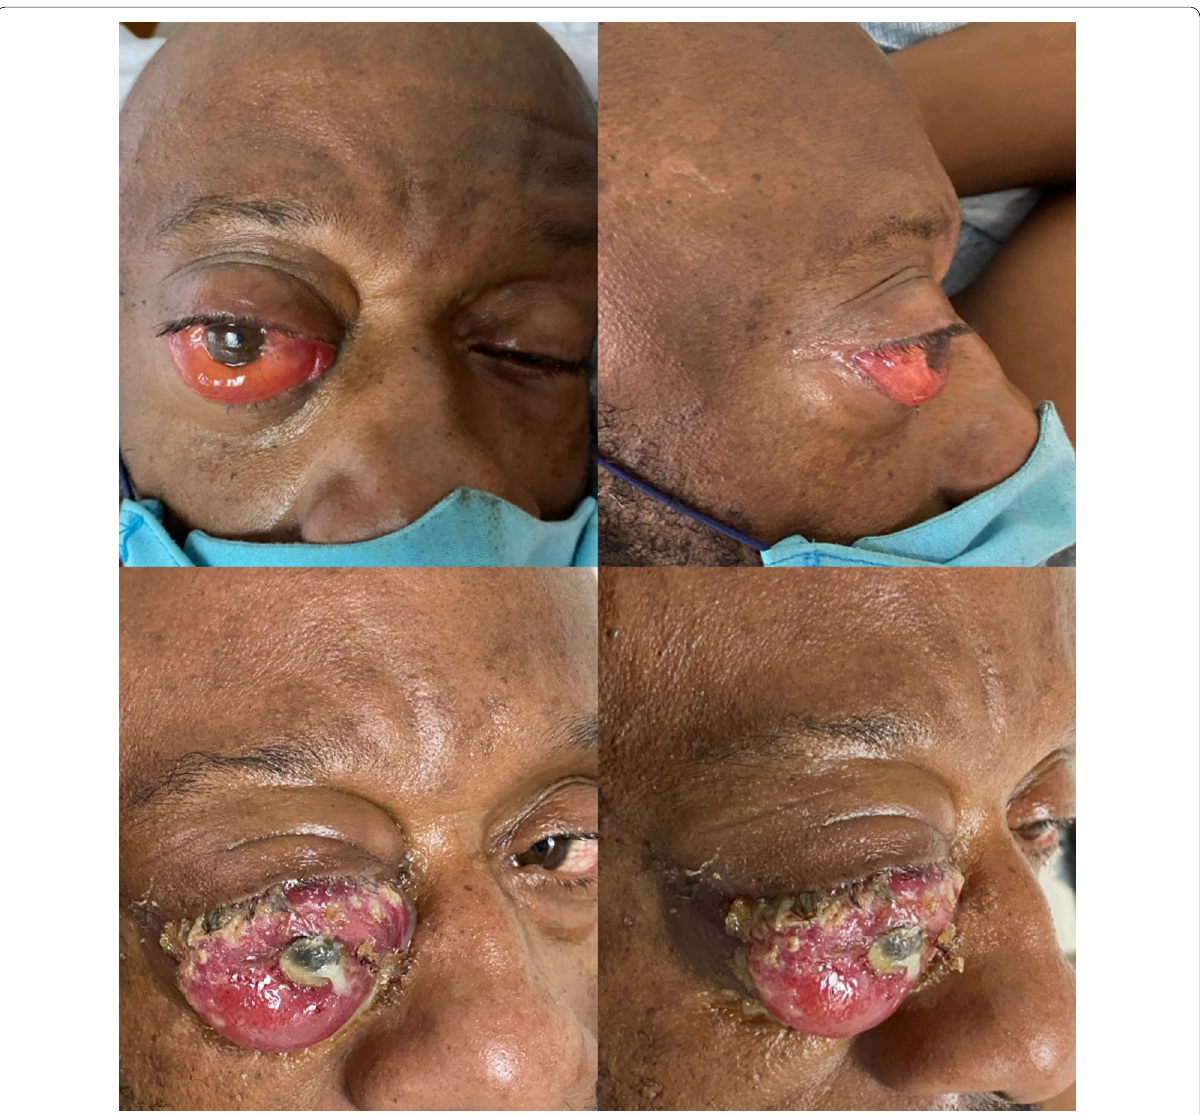
Fig. 3 Top row—admission pictures of patient’s right eye, showing severity of proptosis. Bottom row—one‑week post admission, revealing rapidity of tumour growth and worsening of